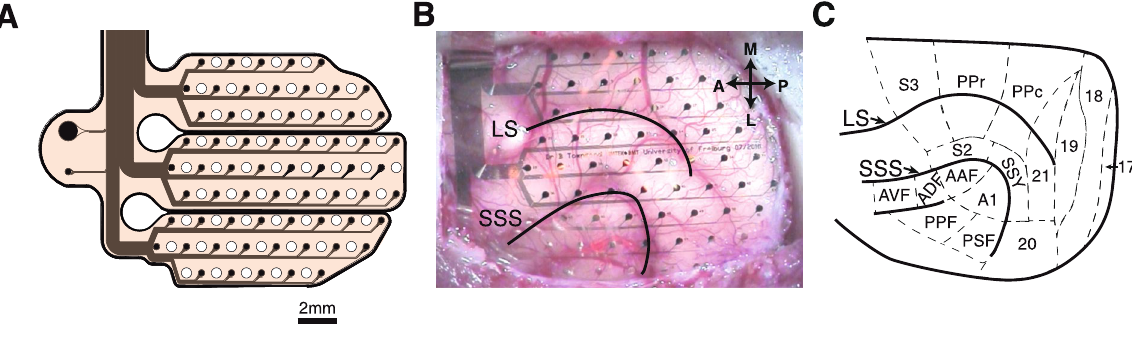
Figure 1. µ ECoG design and placement over ferret posterior cortex. ( A ) The µ ECoG consists of 64 platinum electrodes of 250 µ m diameter distributed across three polymide fingers to enable the array to adapt to the curved surface of the cortex. Inter-electrode spacing was 1.5mm. ( B ) Placement of custom designed µ ECoG array over the left hemisphere during implantation of animal #3. ( C ) Ferret posterior cortex parcellated into 16 functionally and anatomically distinct regions according to Bizley et al . (2007) 53 ). Abbreviations: LS: lateral sulcus; SSS: suprasylvian sulcus; A: anterior; P: posterior; M: medial; L: lateral; S2/S3: somatosensory cortex 2 & 3; PPr/c: rostral/caudal posterior parietal cortex; 17,18,19,20,21: occipital/visual cortex; SSY: suprasylvian field; A1: primary auditory cortex; AAF: anterior auditory field; APF: anterior dorsal field; AVF: anterior ventral field; PPF: posterior pseudosylvian field; PSF: posterior suprasylvian